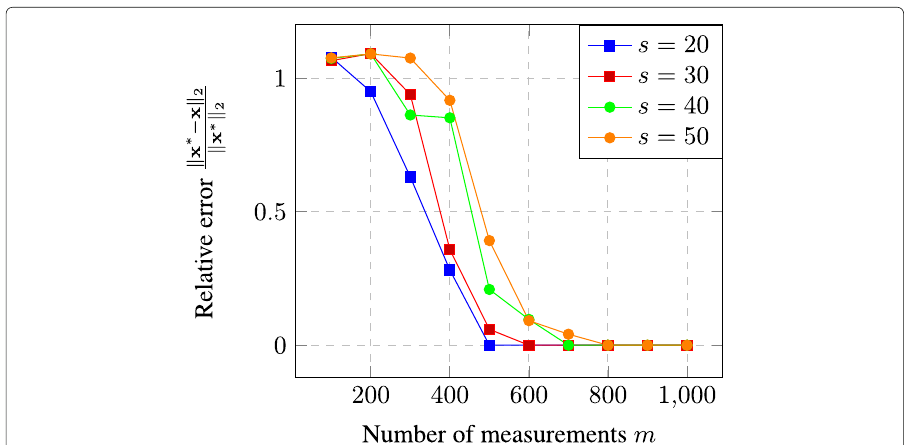
Fig. 5 Mean relative reconstruction error vs no. of measurements ( m ) for MoRAM with (cid:11) x ∗ (cid:11) 2 = 1, n = 1000, and a R = 3.2; with higher sparsity ( s )